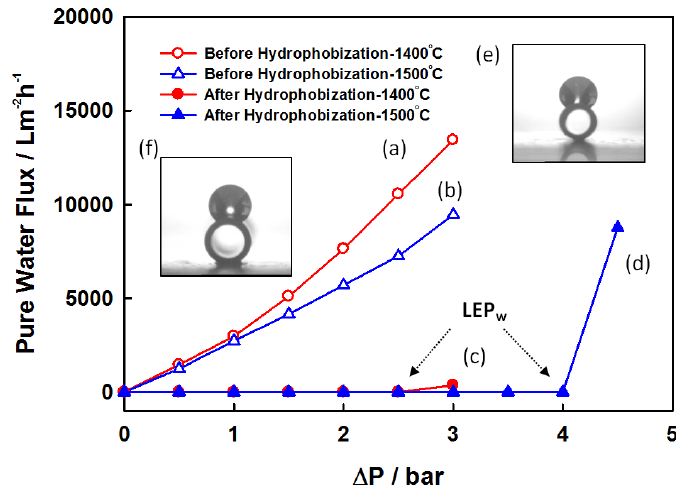
Figure 4. Pure water permeation for as-prepared alumina hollow membrane: before hydrophobization/sintered at ( a ) 1400 °C, ( b ) 1500 °C; after hydrophobization /sintered at ( c ) 1400 °C, ( d ) 1500 °C; contact angle after hydrophobization/sintered at ( e ) 1400 °C, ( f ) 1500 °C.